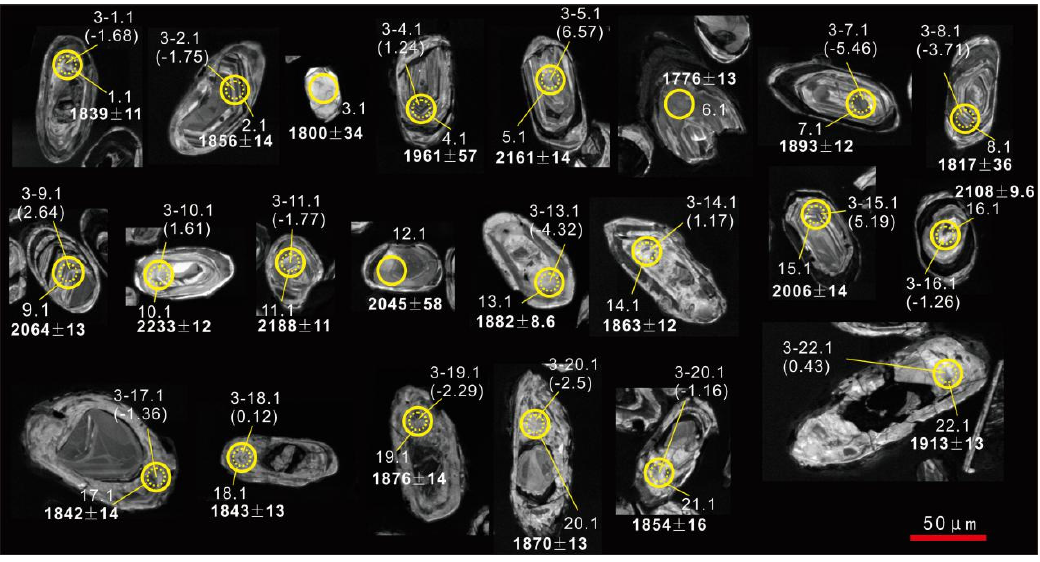
Figure 5. Cathodoluminescence (CL) images for zircons from the basement sample ZJ1-3. Nine analyses for zircon cores and thirteen for zircon rims were conducted for sample ZJ1-3. The zircon cores have 294~592 ppm U and 59~267 ppm Th, and the Th/U ratio ranges from 0.1 to 0.59 (Table 1). In spite of various Pb loss and large discordance, the data define an upper intercept age of 2229 ± 88Ma (MSWD = 2.9) (Figure 6a). Thirteen zircon grains were analyzed for the rim domains. The zircons have a U content of 164~1666 ppm, Th of 3~77 ppm and Th/U radios of 0.01~0.1, consistent with the characters of metamorphic zircon. Points 6.1 and 10.1 show obvious Pb loss and deviate from the concordia line. Except for the 2 disconcordant points, the rest of the 11 analyses yielded an upper intersection point age of 1897 ± 38 Ma (MSWD = 3.1), consistent with the weighted mean 207 Pb/ 206 Pb age (1865 ± 17 Ma, MSWD = 3.5) in the error range (Figure